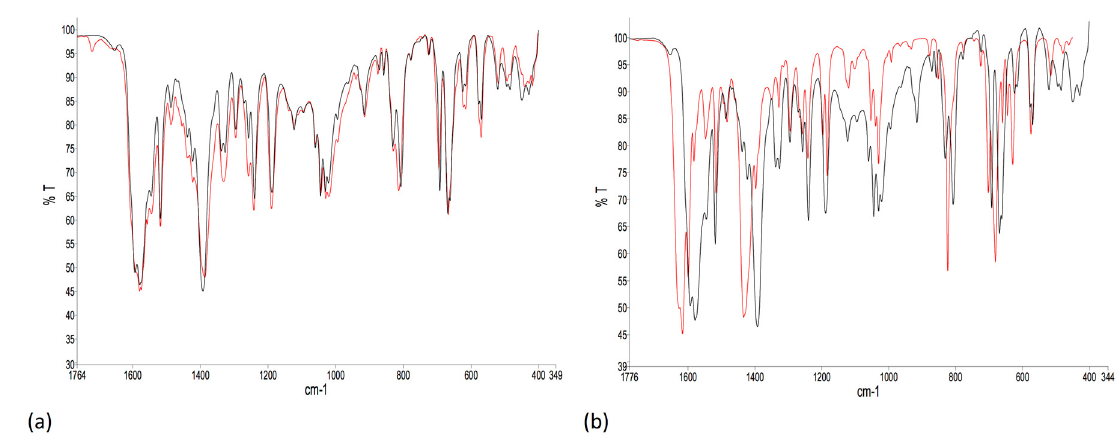
Figure 4. Normalized FT-IR spectra (solid-state) of the bulk materials from ( a ) experiment 1 (black line) and experiment 2 (red line), and ( b ) experiment 1 (black line, [{Cu 4 ( µ 3 -OH) 2 ( µ -OAc) 2 ( µ 3 -OAc) 2 (AcO- κ O) 2 ( 1 ) 2 } · 2MeOH] n ) and the preparative scale reaction (red line, [Cu 2 ( µ -OAc) 4 ( 1 )] n ). Full spectra are given in Figure S9.